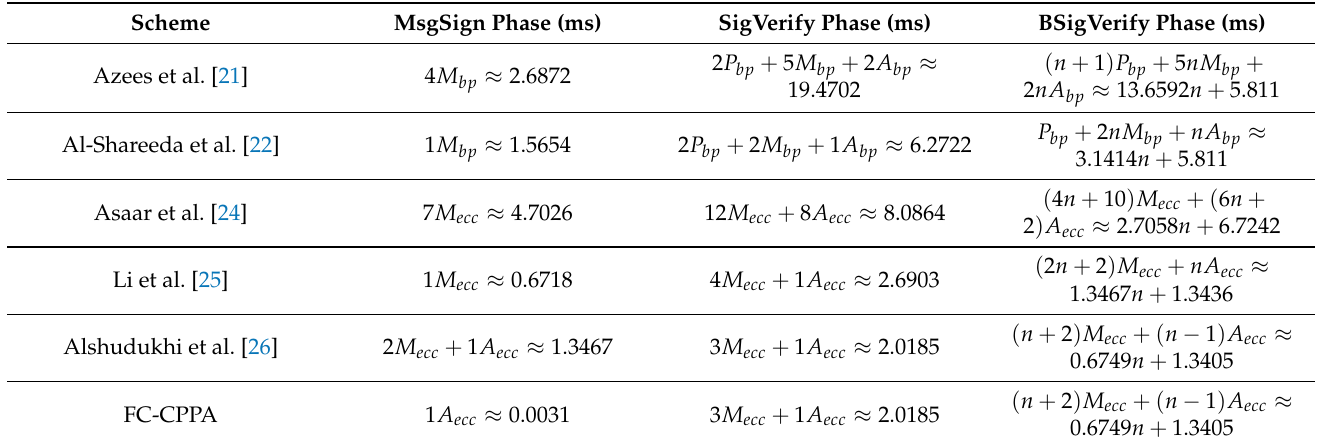
Table 4. Five Authentication Methods and Their Relative Computation